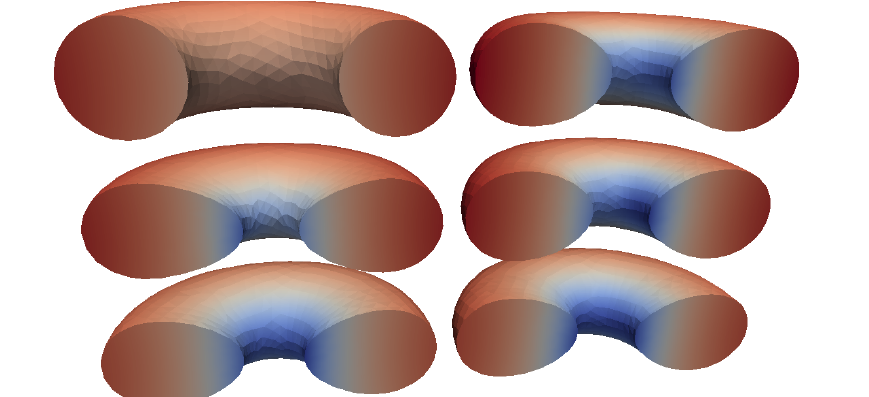
Figure 4. Cross-section sequence over time from the initial torus mesh used for the calculations ( top left ) to the quasi-steady state form found using a wire current of i 2 right ). Indicative colouring corresponds to MVP values. Note the distinctive “egg” shaped minor cross-section that develops over